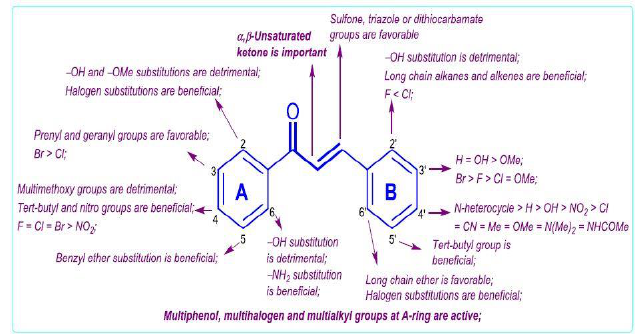
Fig. 2. Comprehensive SAR study of chalcones as antimicrobials